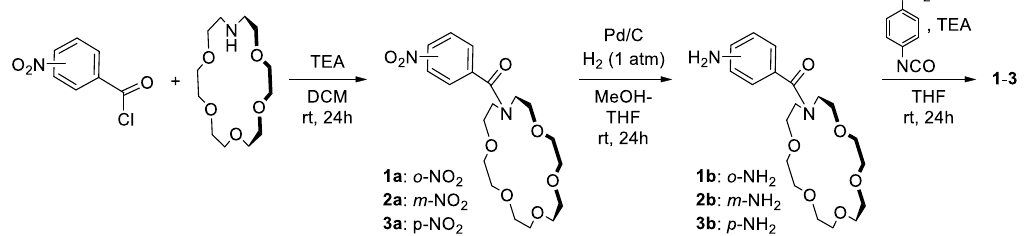
Scheme 1. Three step synthesis of target ditopic ion pair receptors 1 – 3.